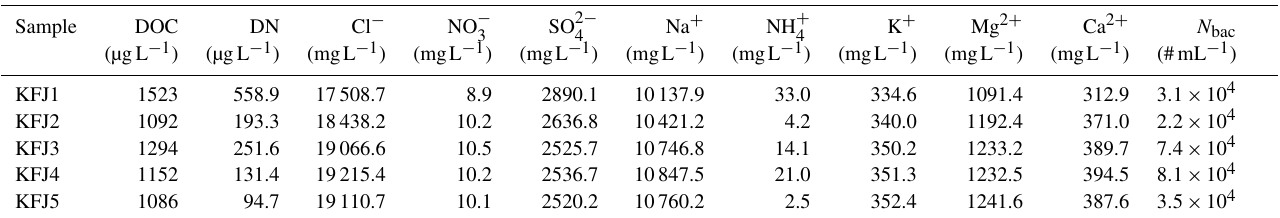
Table A1. Aquatic chemistry and bacterial abundance, N bac , of the five surface seawater samples from Kongsfjorden. See Appendix A for details on the analytical